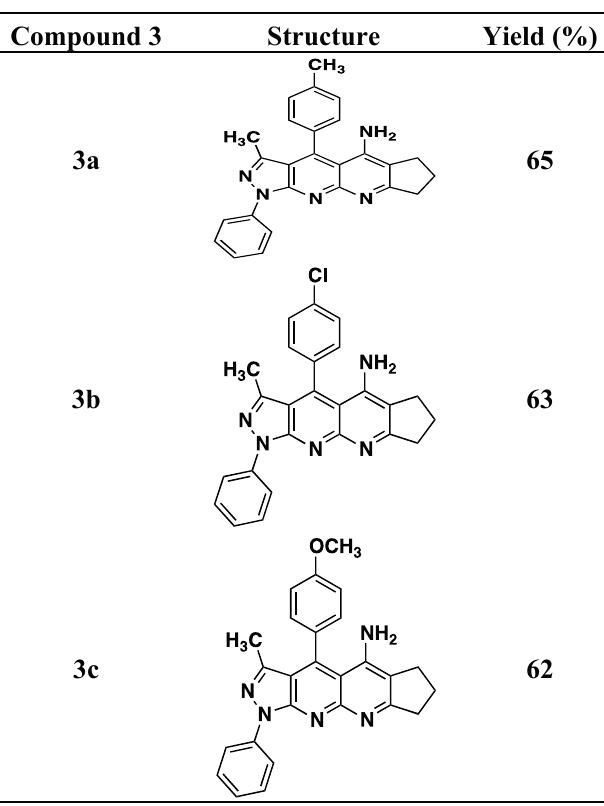
Table 2. Scope of the